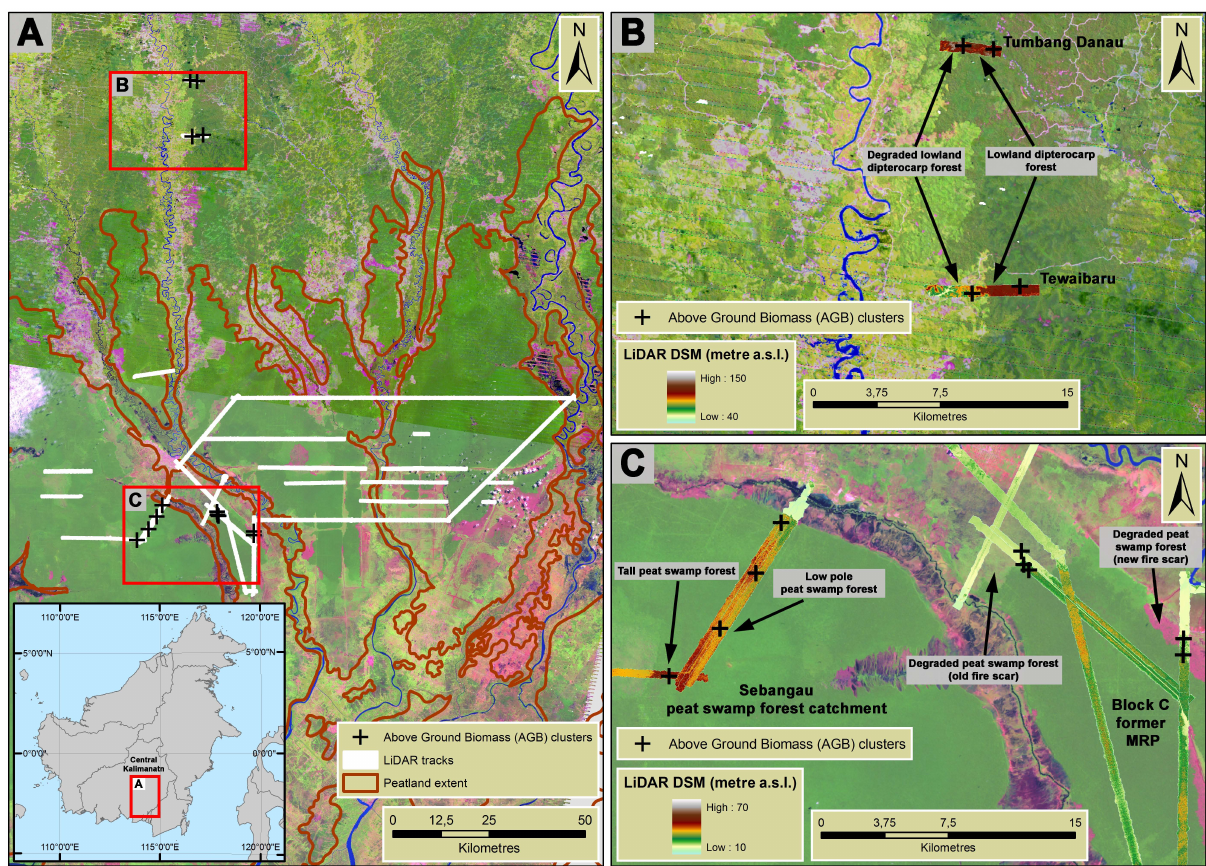
Fig. 1. Location of the LiDAR tracks and above-ground biomass (AGB) clusters (see Methods) (0.13ha, indicated by black + ) in Central Kalimantan, Indonesia, superimposed on a Landsat image (ETM + 118-61, 2009-05-22 and ETM + 118-62, 2007-08-05; bands 5-4-3; and both scenes were gap filled). The red rectangles show the location of (A) , (B) , and (C) . In (B) and (C) also the LiDAR-derived digital surface models (DSM) are